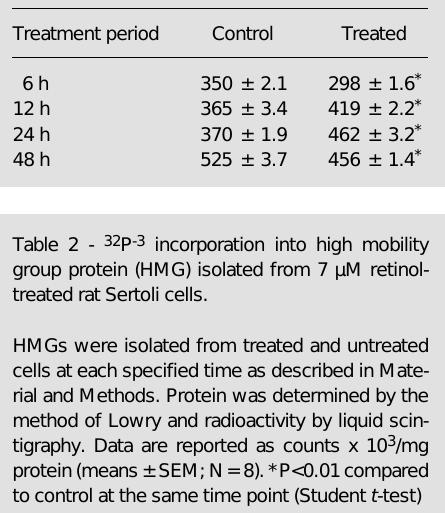
Table 1 - Incorporation of 32 P -3 into histones iso- lated from 7 µM retinol-treated rat Sertoli cells. Histones were isolated from treated and untreated cells at each specified time as described in Mate- rial and Methods. Protein was determined by the method of Lowry and radioactivity by liquid scin- tigraphy. Data are reported as counts x 10 3 /mg protein (means ± SEM; N = 8); *P<0.01 compared to control at the same time point (Student t -test).